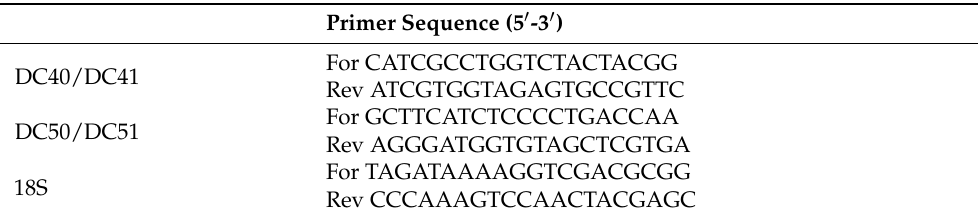
Table 1. List of primers used for semi-quantitative RT-PCR analysis. Primer Sequence (5 (cid:48) -3 (cid:48)